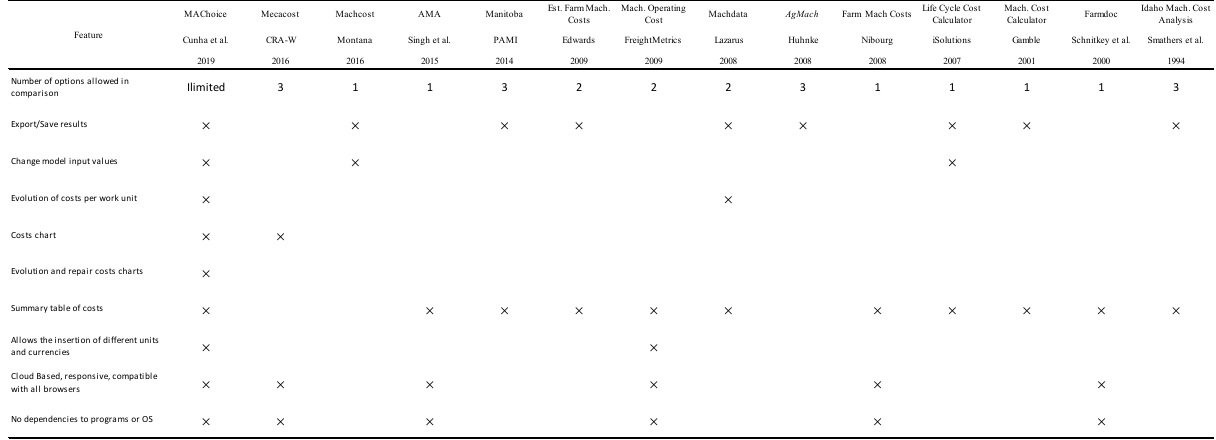
Table 1: Summary of the most relevant features of available tools for agricultural machine costs estimates MAChoice Mecacost Machcost AMA Manitoba Est. Farm Mach.